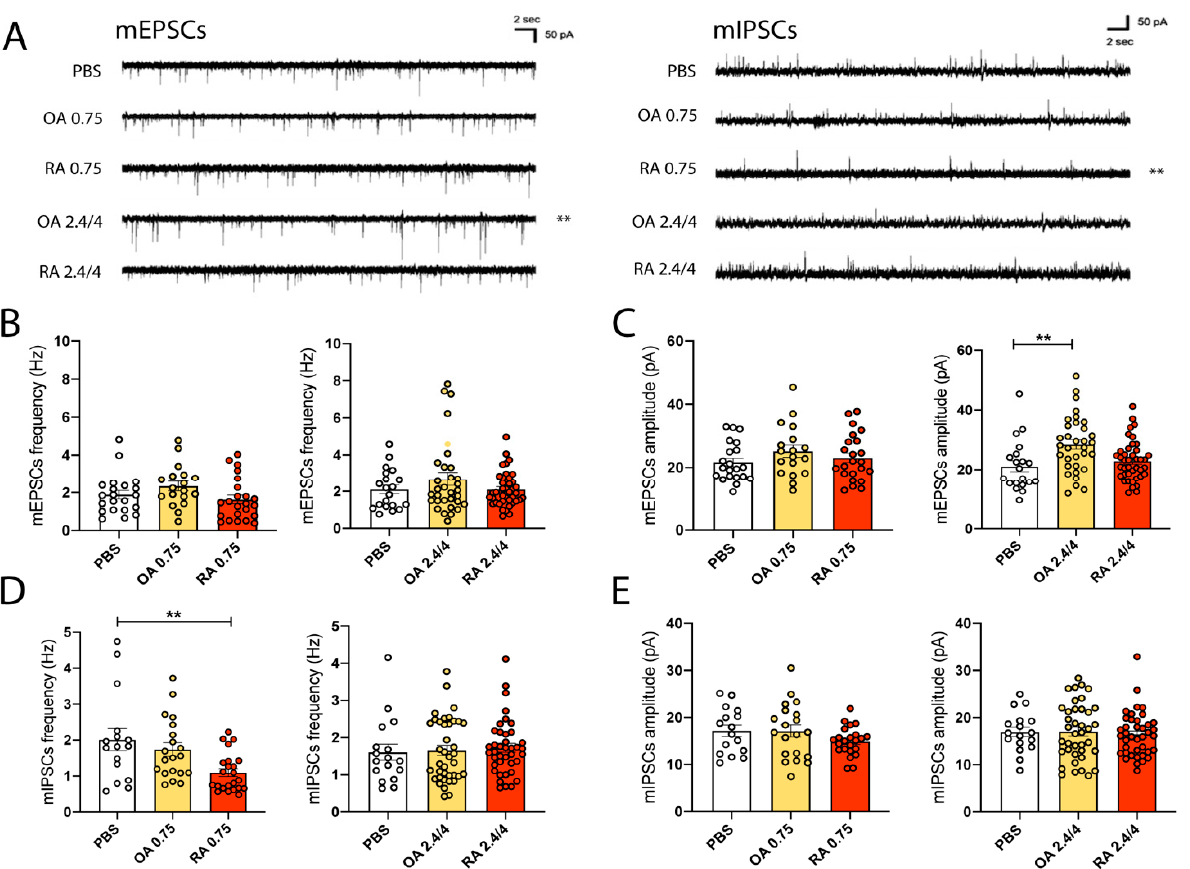
Figure 2. EVs collected from RA and OA synovial fluids lead to increased glutamatergic function but through opposite synaptic changes: electrophysiological results. ( A ) Representative traces of mEPSCs and mIPSCs recorded in 14 DIV hippocampal neurons obtained from wt mouse embryos. ( B ) Analysis of mEPSCs frequency recorded after two hours exposure to OA- and RA-EVs at low (0.75 μ g/mL) or medium/high (2.4 and 4 μ g/mL) concentration from cultured neurons (low concentration: Kruskal–Wallis test followed by Dunn’s multiple comparison test, ns; number of recorded neurons: PBS = 21, OA = 18, RA = 23; medium/high concentration: Kruskal–Wallis test followed by Dunn’s multiple comparison test, ns; number of recorded neurons: PBS = 20, OA = 32, RA = 41). ( C ) Analysis of mEPSCs amplitude recorded after two hours exposure to OA- and RA- EVs at low (0.75 μ g/mL) or medium/high (2.4 and 4 μ g/mL) concentration from cultured neurons (low concentration: Ordinary one-way ANOVA followed by Tukey’s multiple comparison test, ns; number of recorded neurons: PBS = 21, OA = 18, RA = 23; medium/high concentration: Kruskal–Wallis test followed by Dunn’s multiple comparison test, ** p < 0.01; number of recorded neurons: PBS = 20, OA = 33, RA = 41). ( D ) Analysis of mIPSCs frequency recorded after two hours exposure to OA- and RA-EVs at low (0.75 μ g/mL) or medium/high (2.4 and 4 μ g/mL) concentration from cultured neurons (low concentration: Ordinary one-way ANOVA followed by Tukey’s multiple comparison test, ** p < 0.01; number of recorded neurons: PBS = 16, OA = 20, RA = 23; medium/high concentration: Kruskal–Wallis test followed by Dunn’s multiple comparison test, ns; number of recorded neurons: PBS = 17, OA = 39, RA = 40). ( E ) Analysis of mIPSCs amplitude recorded after two hours exposure to OA- and RA-EVs at low (0.75 μ g/mL) or medium/high (2.4 and 4 μ g/mL) concentration from cultured neurons (low concentration: Ordinary one-way ANOVA followed by Tukey’s multiple comparison test, ns; number of recorded neurons: PBS = 16, OA = 20, RA = 23; medium/high concentration: Kruskal–Wallis test followed by Dunn’s multiple comparison test, ns; number of recorded neurons: PBS = 17, OA = 39, RA = 40).